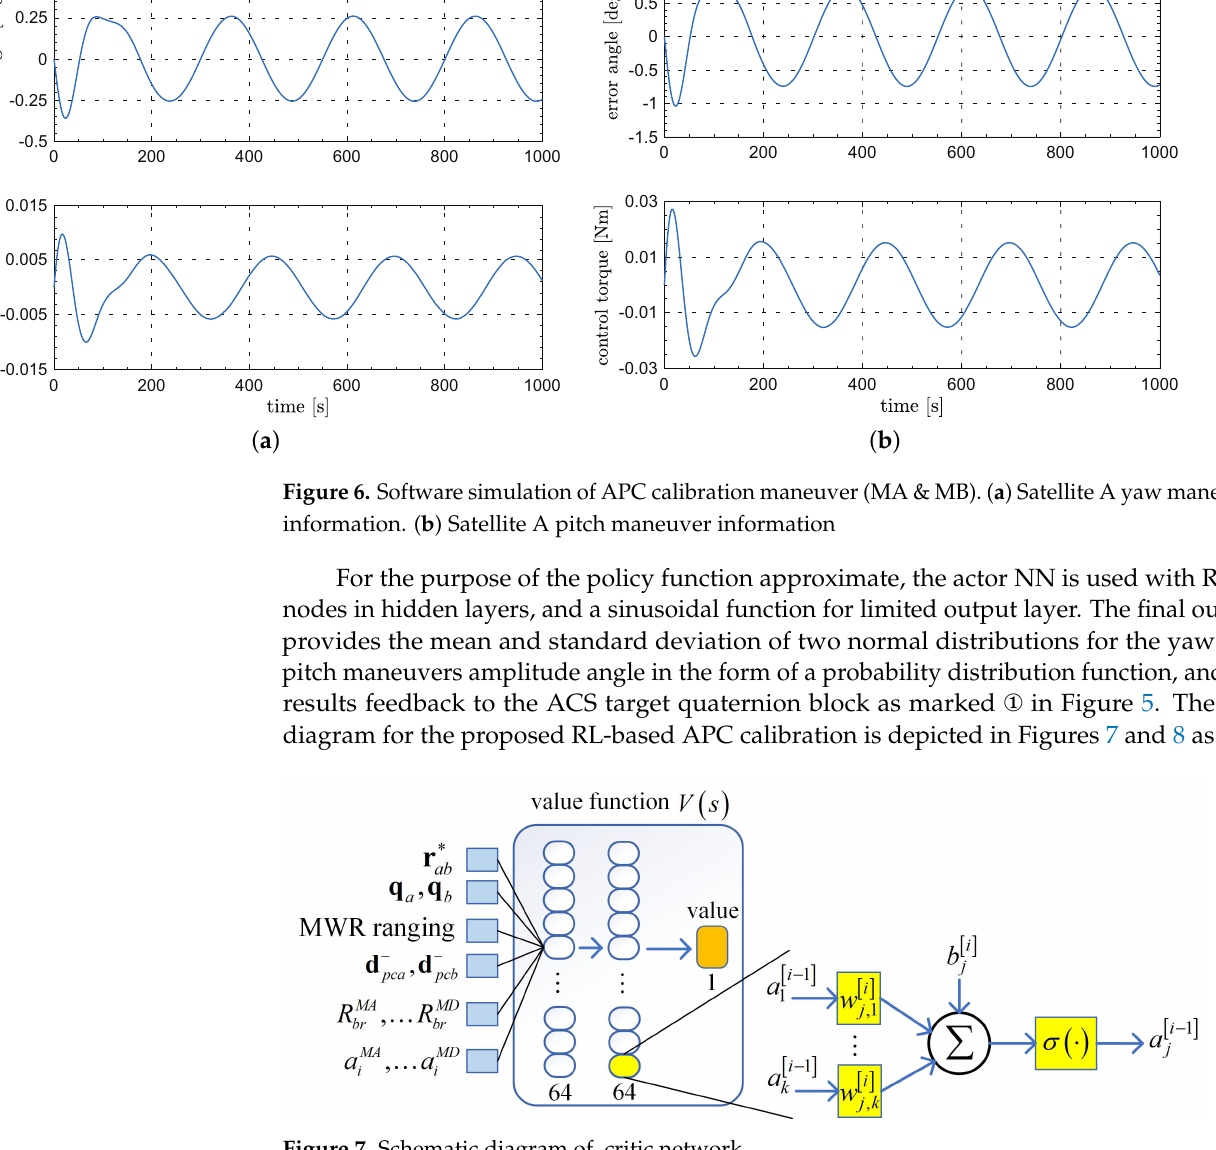
Figure 7. Schematic diagram of critic